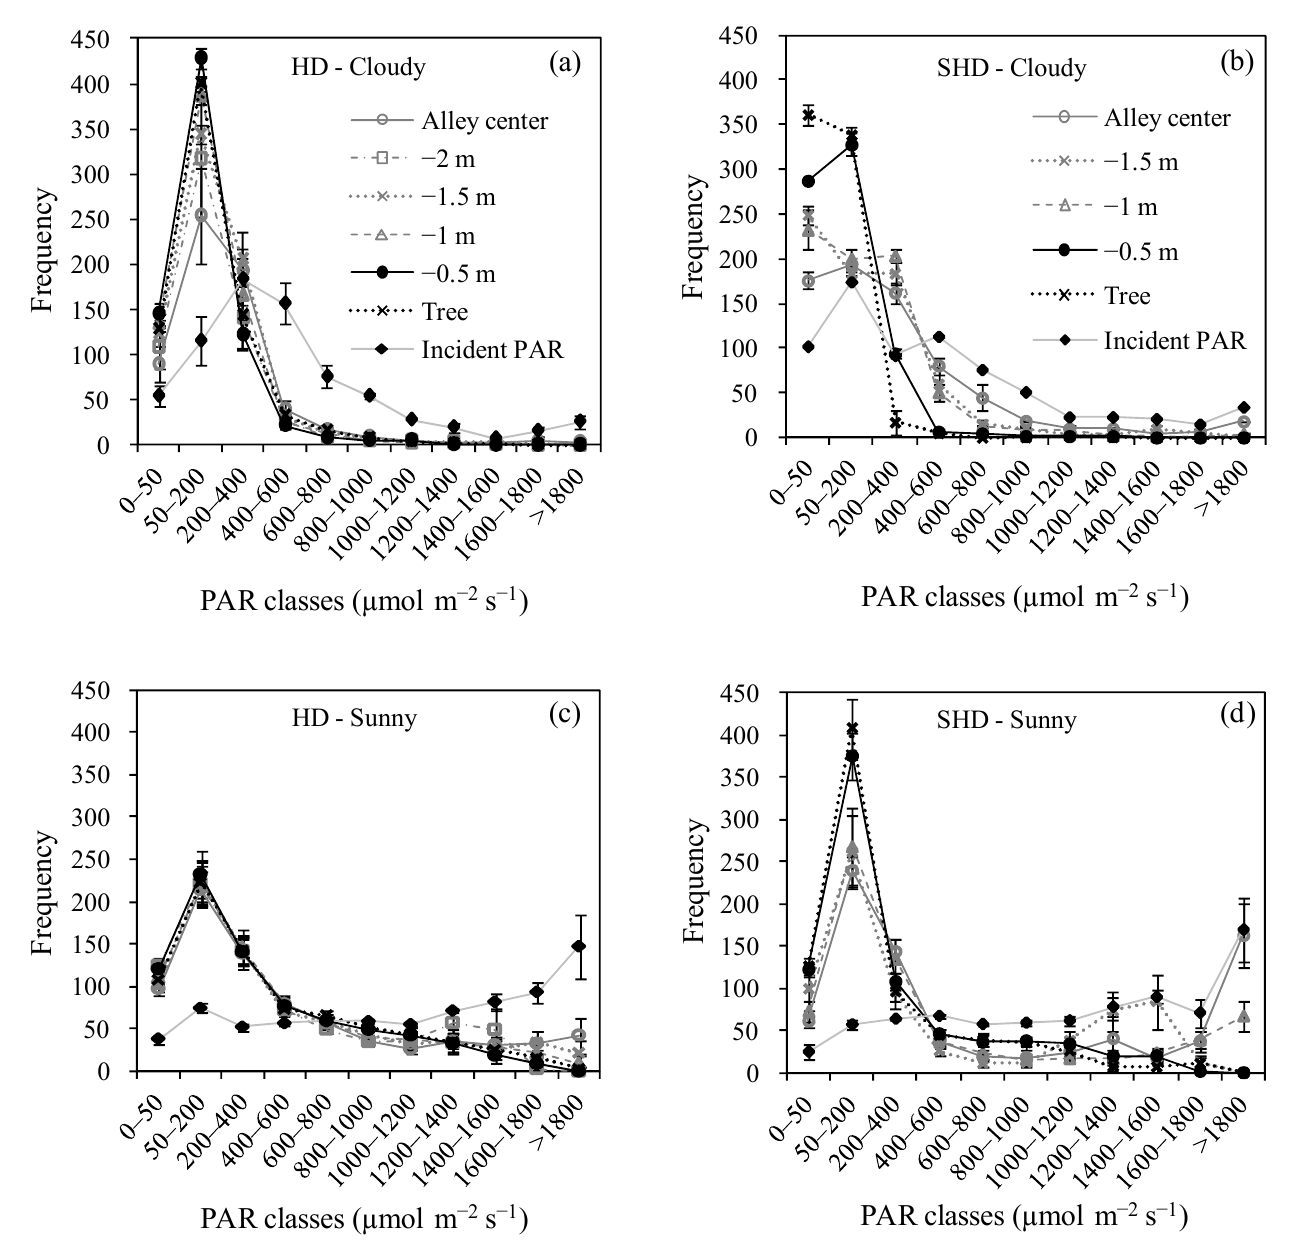
Figure 4. Class frequency distribution (mean of all available data) of incident (i.e., above the canopy) and transmitted PAR values as measured every minute, from dawn to dusk, at increasing distance (0.5 m steps) from the tree row along the west side of the transects, up to the middle of the alley, in a high-density (HD) and a super high-density (SHD) system. Data are means of all measurement days, separated in overcast ( a , b ) and clear or sunny ( c , d ) days, in both the HD ( a , c ) and the SHD ( b , d ) systems. Due to limitations in datalogger channels, measurements were made in different days for the two systems, as shown by the slightly different class frequency distribution patterns for the incident PAR. For statistical differences between positions, within each PAR class, see Table